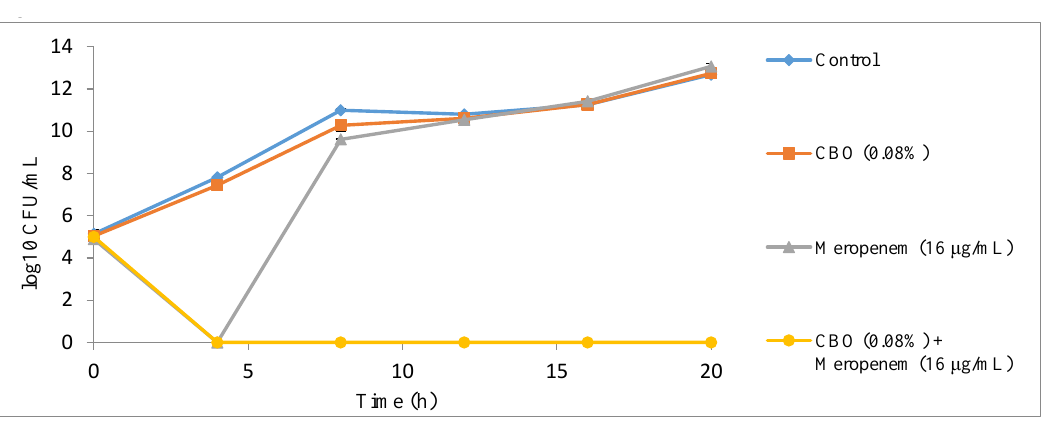
Figure 1. A 4-hour interval killing curve for CBO and meropenem alone, and in combination against K. pneumoniae BAA-1705.